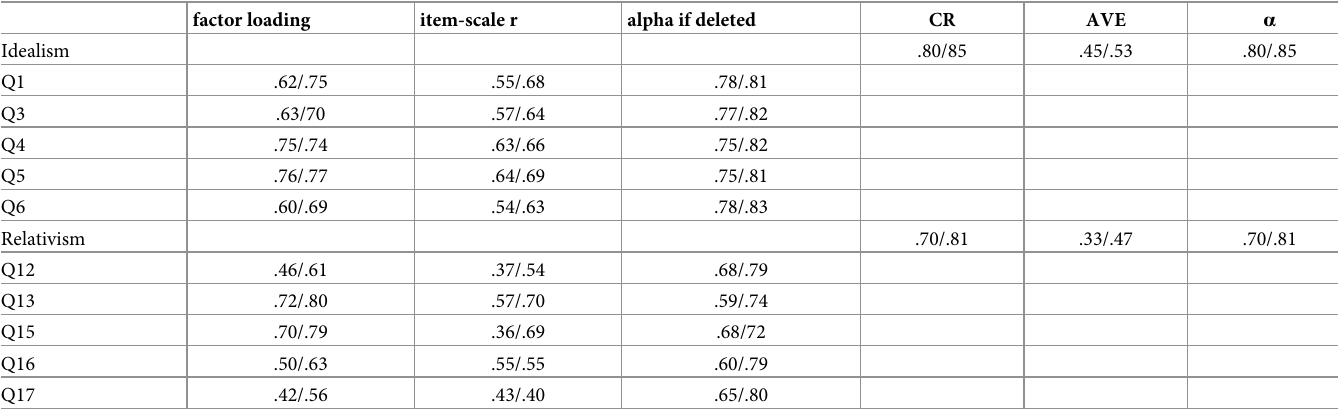
Table 3. Psychometrics for EPQ for Study 1 (left) and Study 2